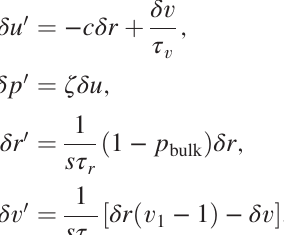
FIG. 9. Time series of the instantaneous estimate of the dimensionless half-decay length for τ values are stable after ∼ 20 τ reported in such a steady-state regime using improved averaging over all data in that